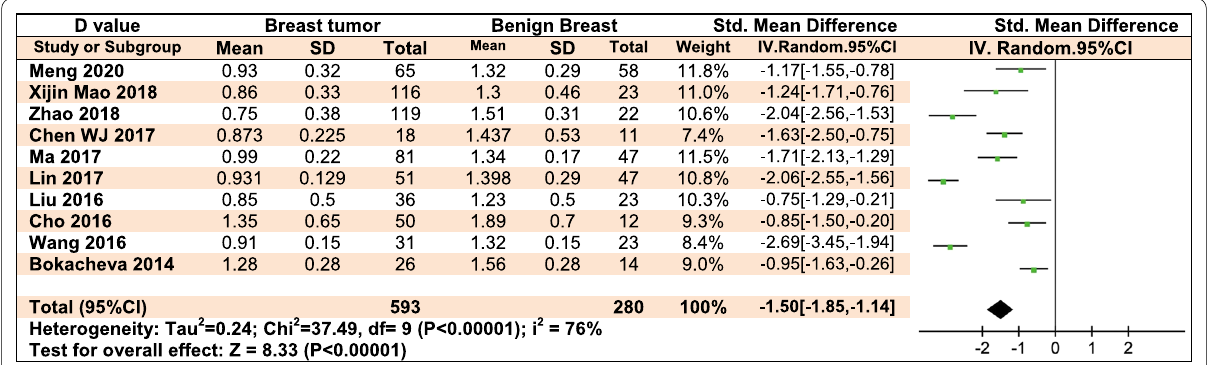
Fig. 3 The mean value of the true diffusivity ( D ) distinguished among breast lesions